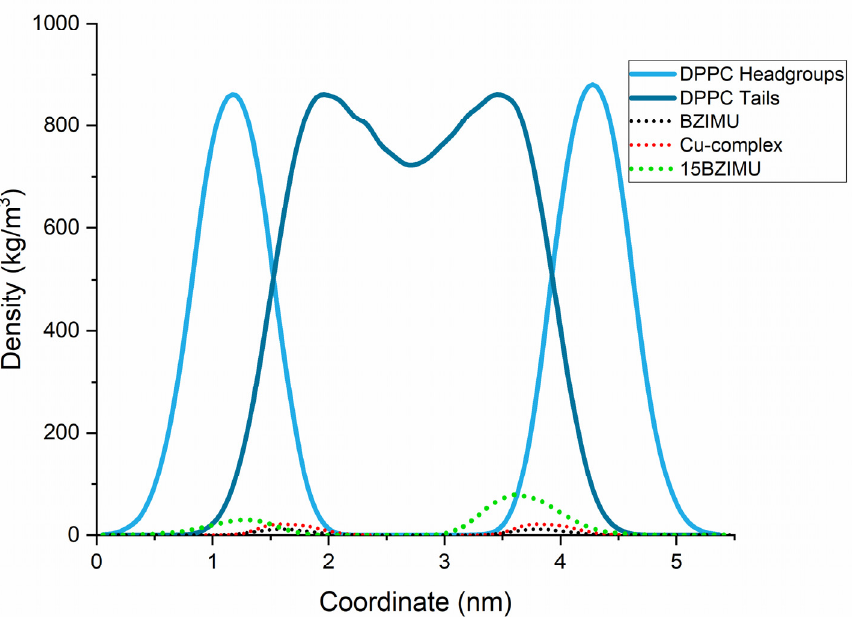
Figure 2. Partial density profiles along the bilayer normal ( z -axis). 15BZIMU indicates the presence of fifteen BZIMU molecules.